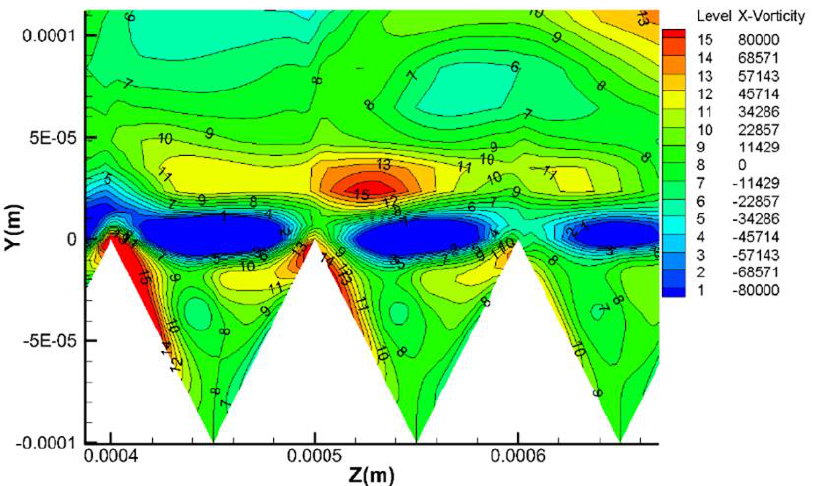
Figure 21. Vorticity cloud picture in the flow direction of triangular groove in the spanwise plane at x = 0.00375 m.